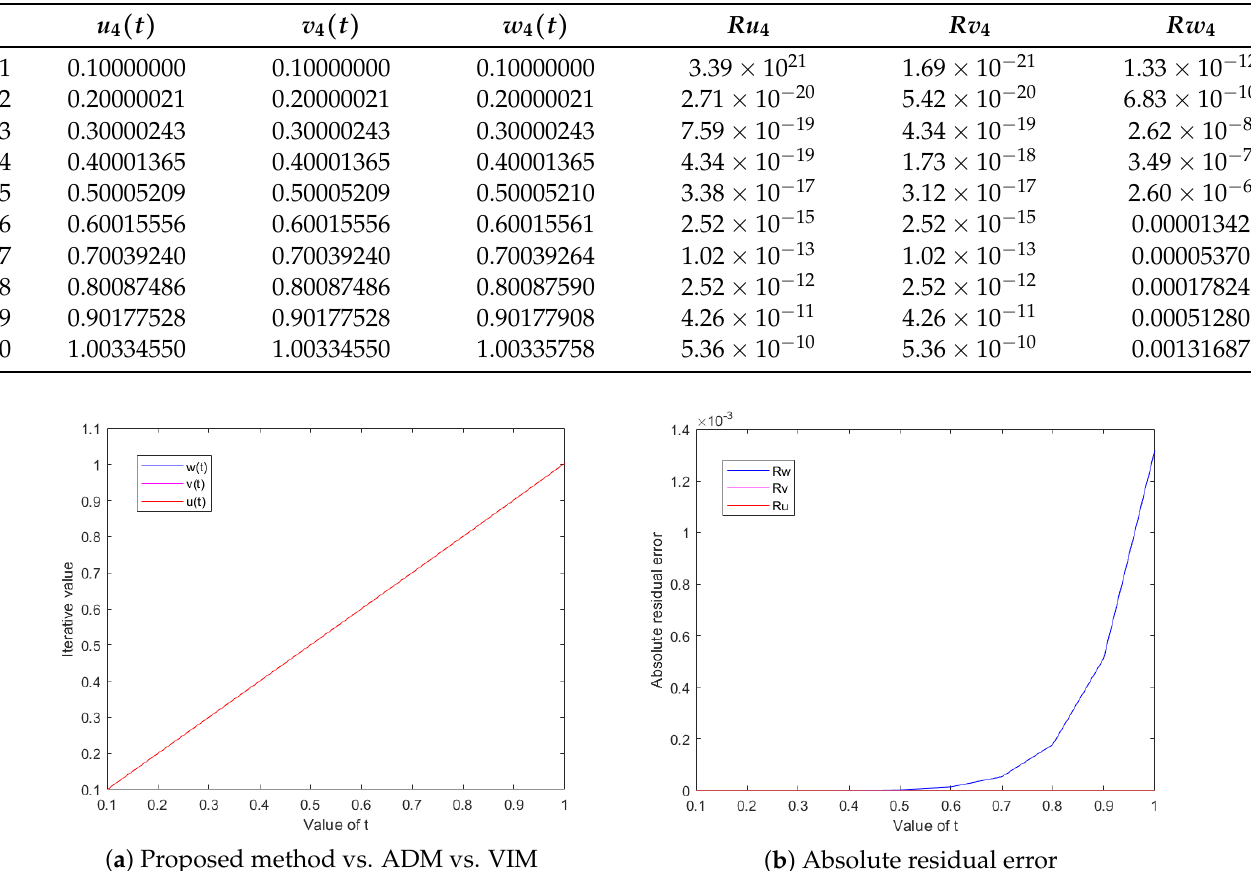
Figure 1. Comparison of numerical solutions and absolute residual errors obtained by the proposed method and existing methods for 0 ≤ t ≤ 1 of Example